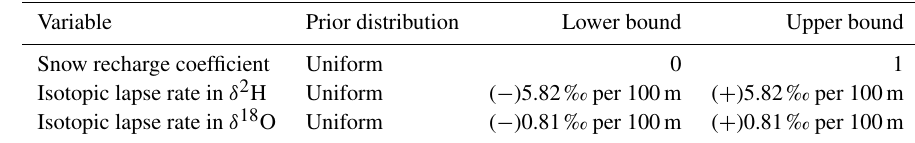
Table 2. Prior distribution of the different model parameters as specified to HydroMix.